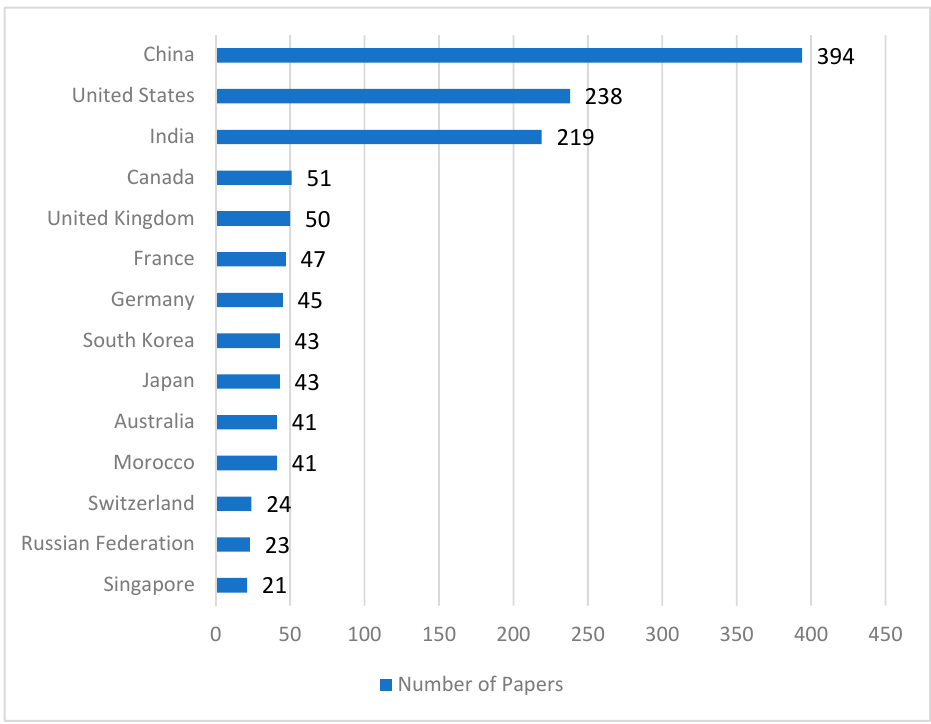
Figure 14. Ranking of contributions by different countries.